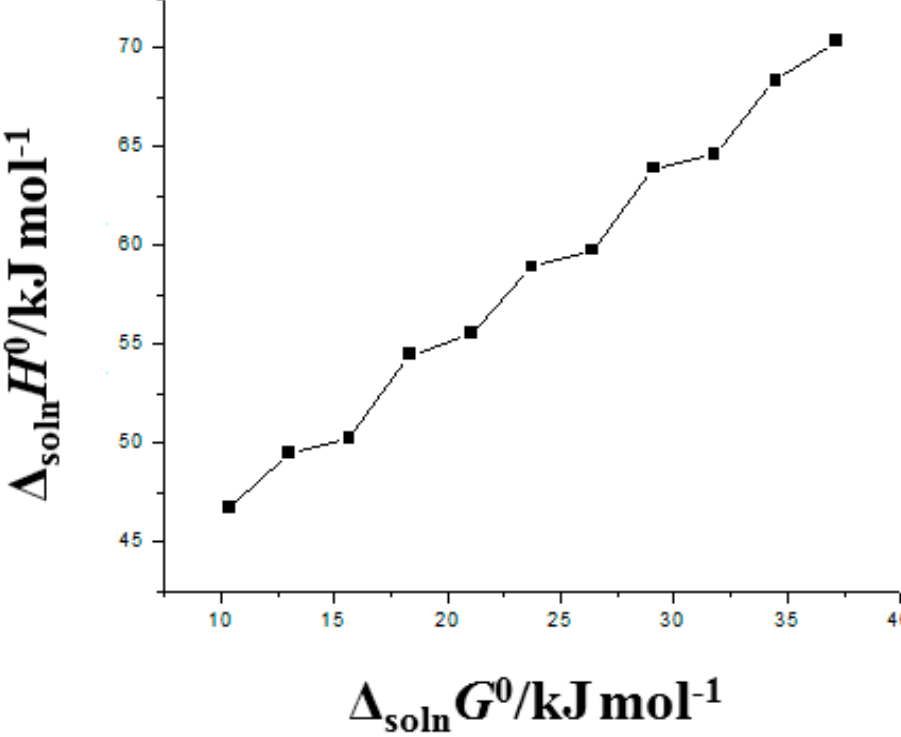
Figure 6. ∆ sol H ◦ vs. ∆ sol G ◦ enthalpy–entropy compensation graph for solubility of FXT in various Figure 6. Δ sol H° vs. Δ sol G° enthalpy–entropy compensation graph for solubility of FXT in various {PEG 400 (1) + H 2 O (2)} mixtures at T hm = 308 {PEG 400 (1) + H 2 O (2)} mixtures at T hm = 308 K.